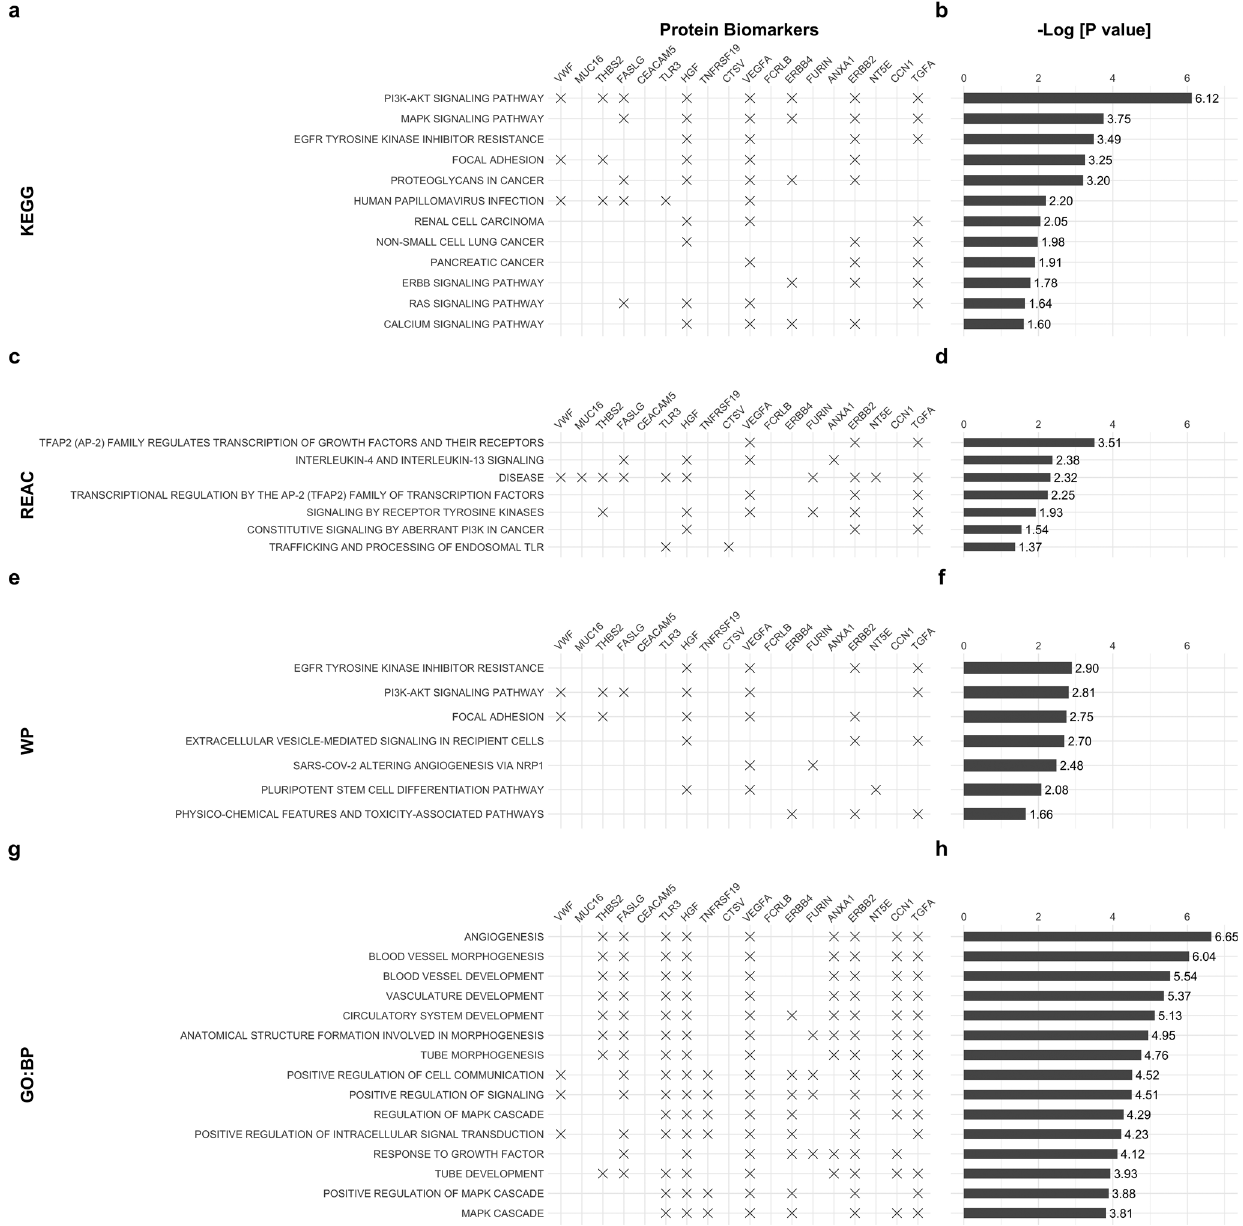
Fig. 3 Enrichment analysis. g:Pro fi ler terms for the set of features selected by the optimal classi fi er trained in 0-4 + samples. a Kyoto Encyclopaedia of Genes and Genomes (KEGG) pathways. c Reactome Pathway Database (REAC). e WikiPathways (WP). g Gene ontology terms biological process (GO: BP). The respective adjusted p -values associated with each enrichment term or pathway are plotted in ( b ), ( d ), ( f ) and ( h ). See also Fig. 2. See ‘ Statistical analysis ’ in Methods for further details and Supplementary Data